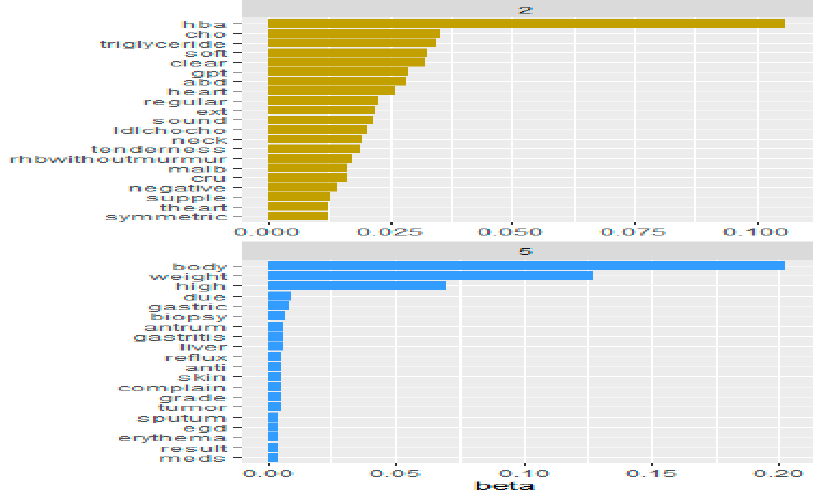
Figure 7. Word frequency distribution of 20 words in six topics (E11 Topics 2 and